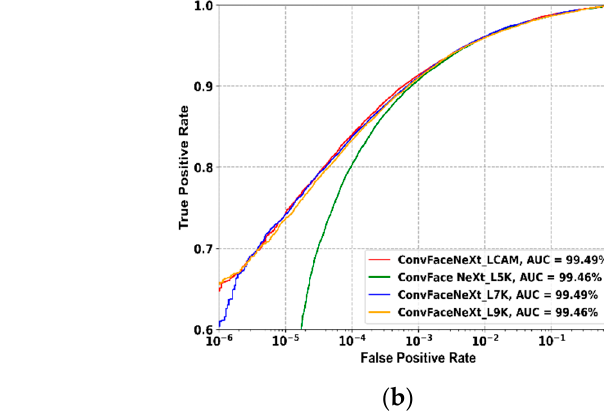
Figure 5. ROC curves of 1:1 veri fi cation for di ff erent kernel sizes. ( a ) IJB-B dataset; ( b ) IJB-C dataset.